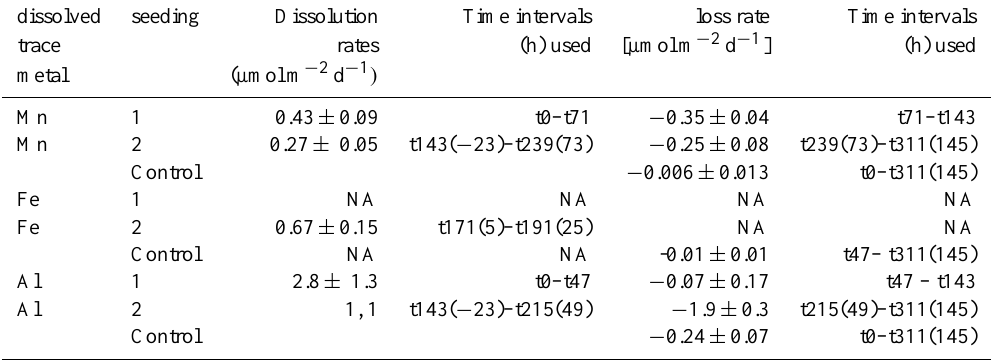
Table 3. Mn, Fe and Al dissolution and loss rates in µmolm − 2 d − 1 ( ± 1 σ ). They were calculated as the increase/decline of each metal in each of the dust seeded mesocosms by applying a linear regression to the inventory as a function of time. For the dissolution rates the calculation was started at the point before each of the seedings until the point in time when the concentration reached its maximum. For the loss rates the calculation was started at the point after each of the seedings when the concentration was the